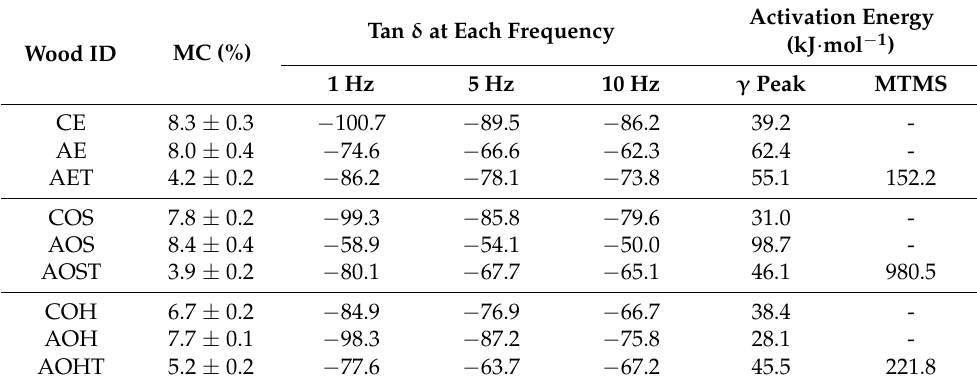
Table 4. The activation energy for γ -peaks and MTMS peaks of contemporary and archaeological untreated and treated wood